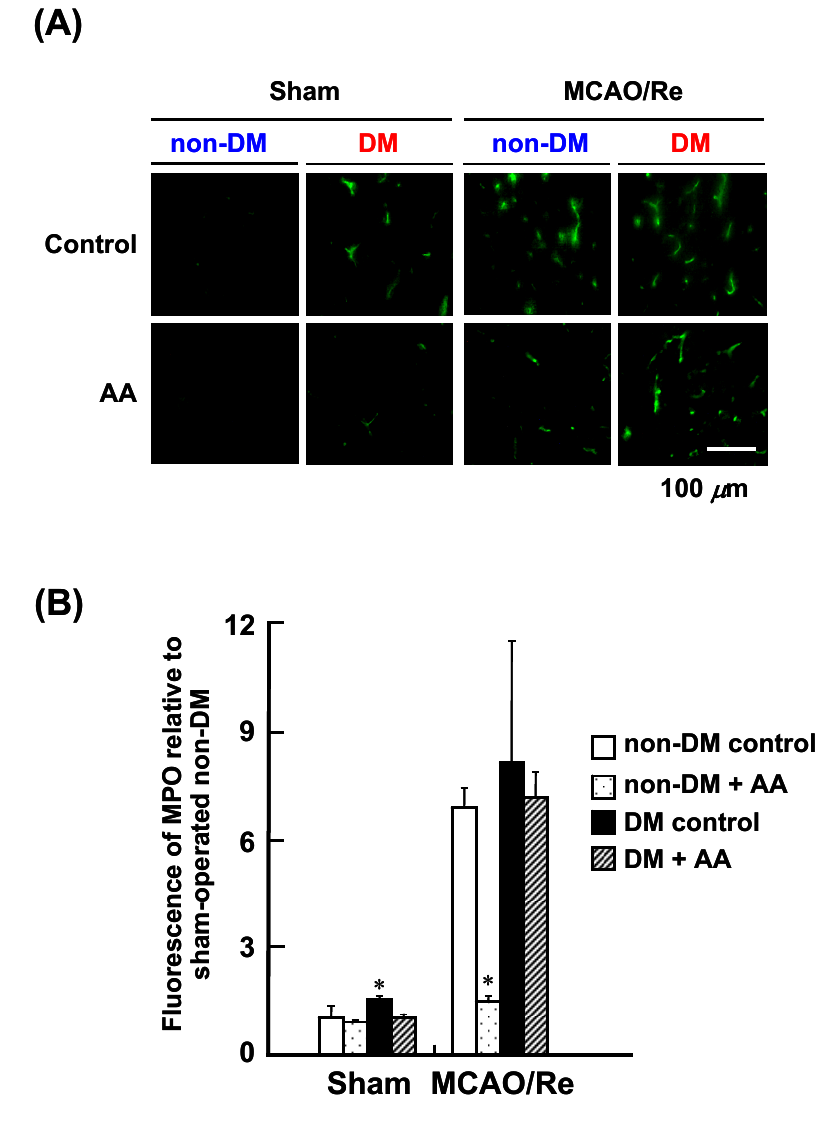
Figure 7. Effects of AA supplementation on MPO expression after MCAO/Re in the brain of nondiabetic and diabetic rats. ( A ) Representative photographs of MPO immunostaining in the cortex coronal sections of nondiabetic and diabetic rats; ( B ) Quantitative analysis of MPO fluorescence intensity in the cortex. The data are presented as mean ± SD ( n = 3–4). * p < 0.05 compared with the nondiabetic control group. DM in the figure denotes diabetic, while non-DM denotes